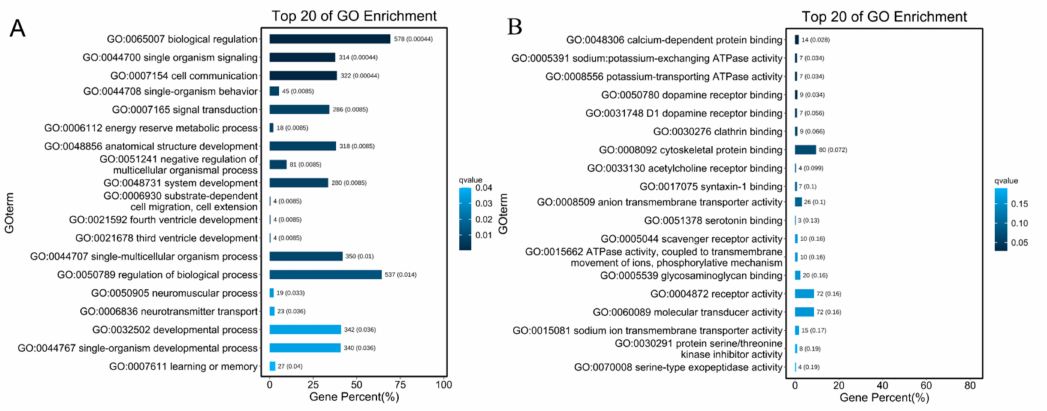
Figure 8. The top 20 of GO enrichment of DE-lncRNAs co-expressed with mRNAs in heart. ( A ) The top 20 of GO enrichment for Biological Process. ( B ) The top of GO enrichment for molecular function. The numbers to the right of bars mean the number of DE-lncRNAs in specific enriched GO terms and the numbers in brackets mean the q